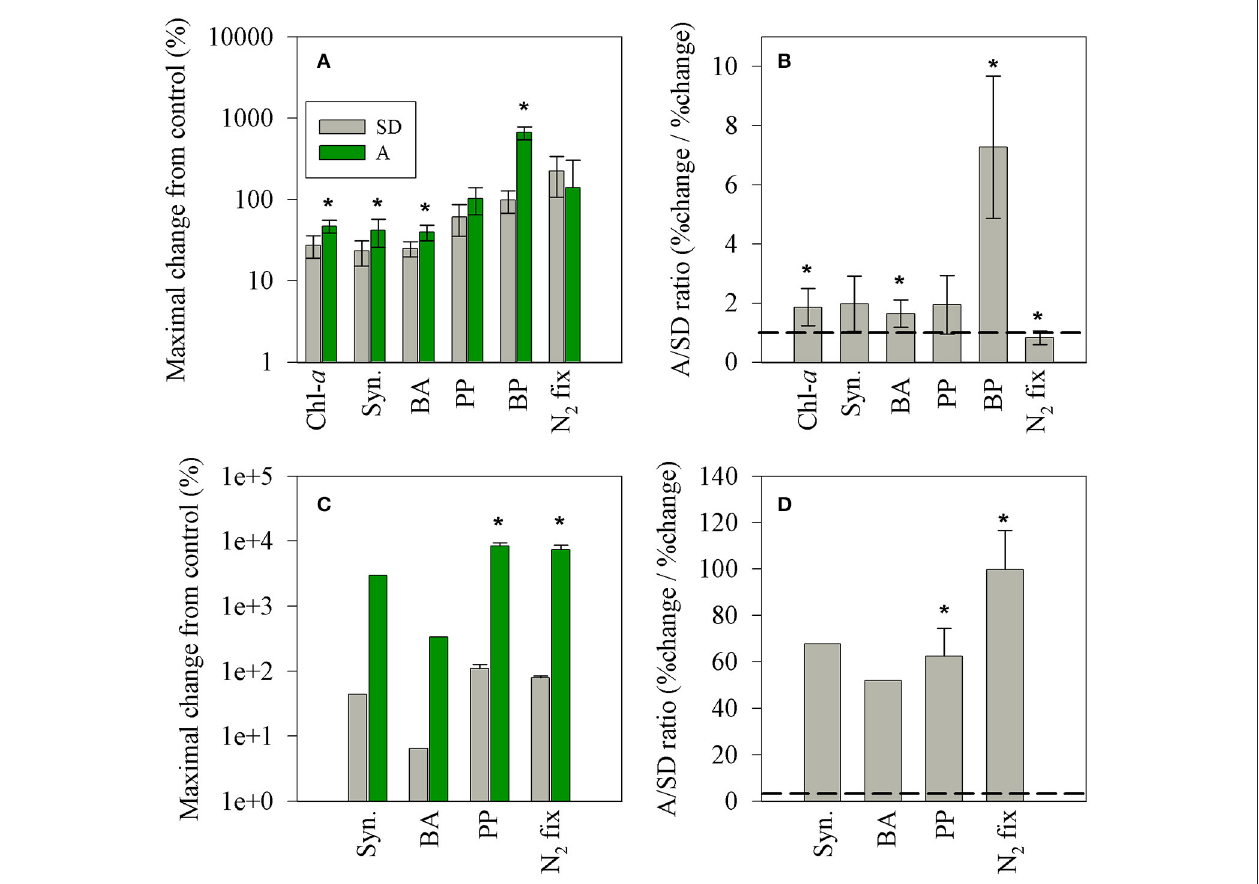
FIGURE 6 | The maximal net changes (normalized to 1mg l − 1 dust) in autotrophic and heterotrophic microbial populations (A,C) and the A/SD ratio (B,D) measured in this study (A,B) and that reported in the BOUM campaign (Station B, Ternon et al., 2011, C,D) . The black line represents a 1:1 ratio between A and SD values. The asterisks above the columns represent statistically significant differences (one-way ANOVA and a Fisher LSD means comparison test, P <